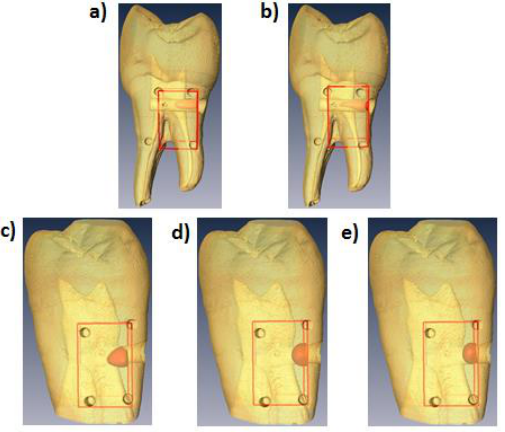
Figure 7. Merged LOT and micro-CT images. ( a , b ) 1 mm depth hole with concentrations 26 µM and 13 µM respectively. ( c , d , e ) 2 mm depth hole with concentrations of 26 µM, 13 µM and 6.5 µM.